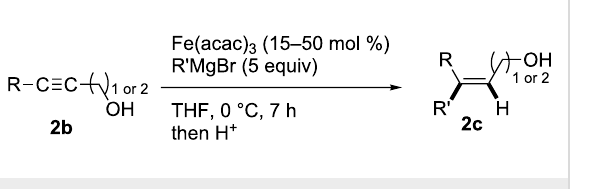
Scheme 7: Iron-catalyzed syn- carbomagnesiation of propargylic or homopropargylic alcohol.